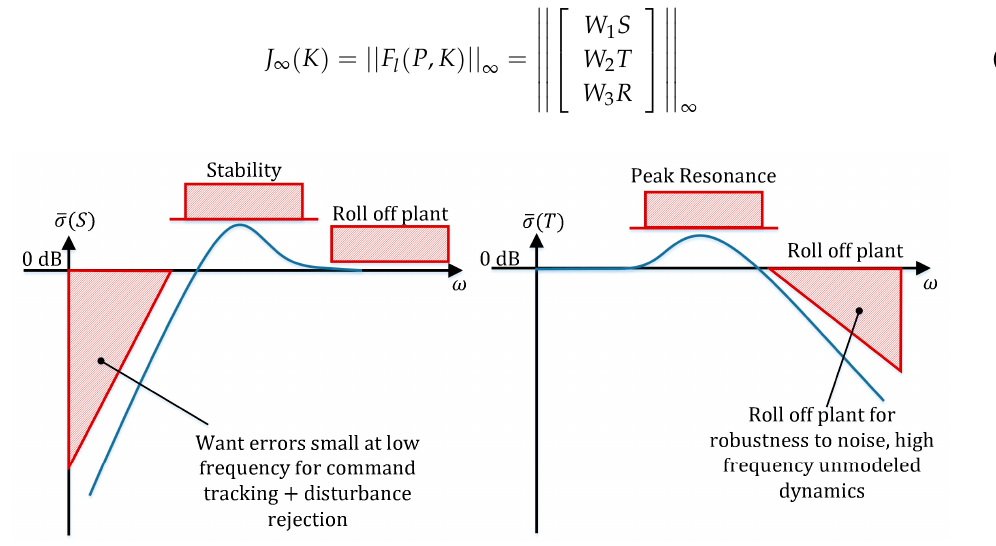
Figure 7. Singular value frequency response performance requirements for sensitivity and complementary sensitivity functions (taken from [34] with permission).